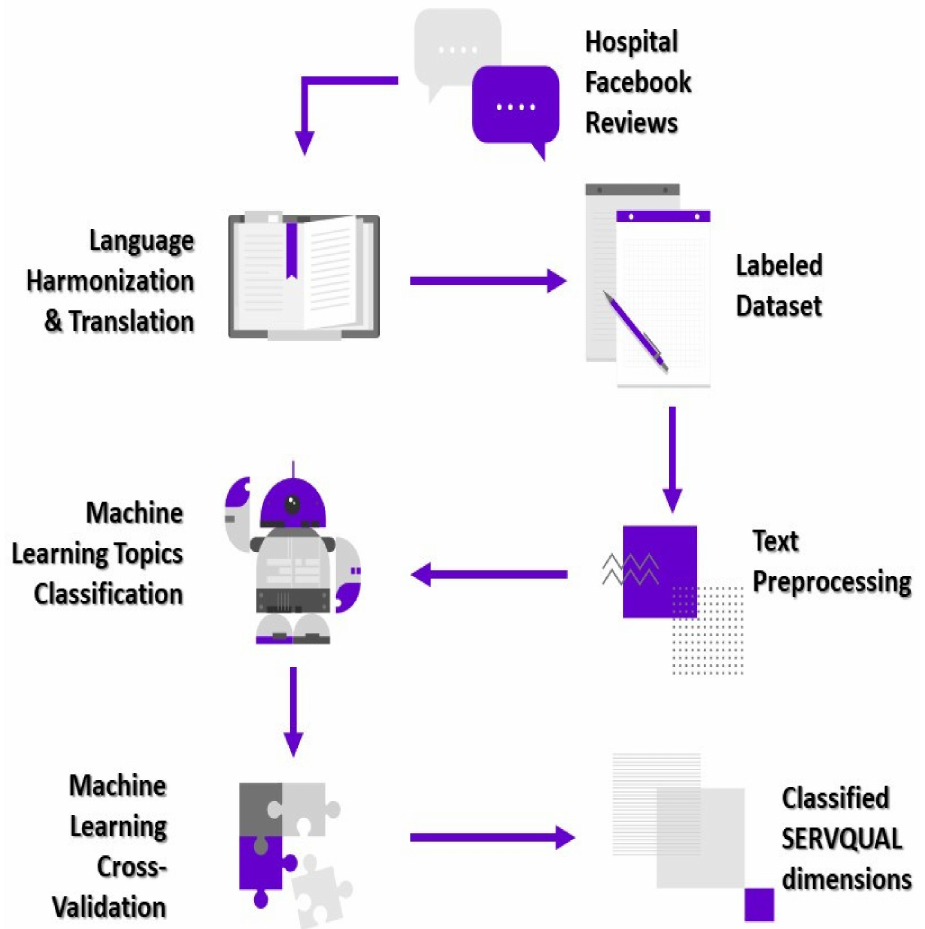
Figure 2. General architecture of proposed methodology in this